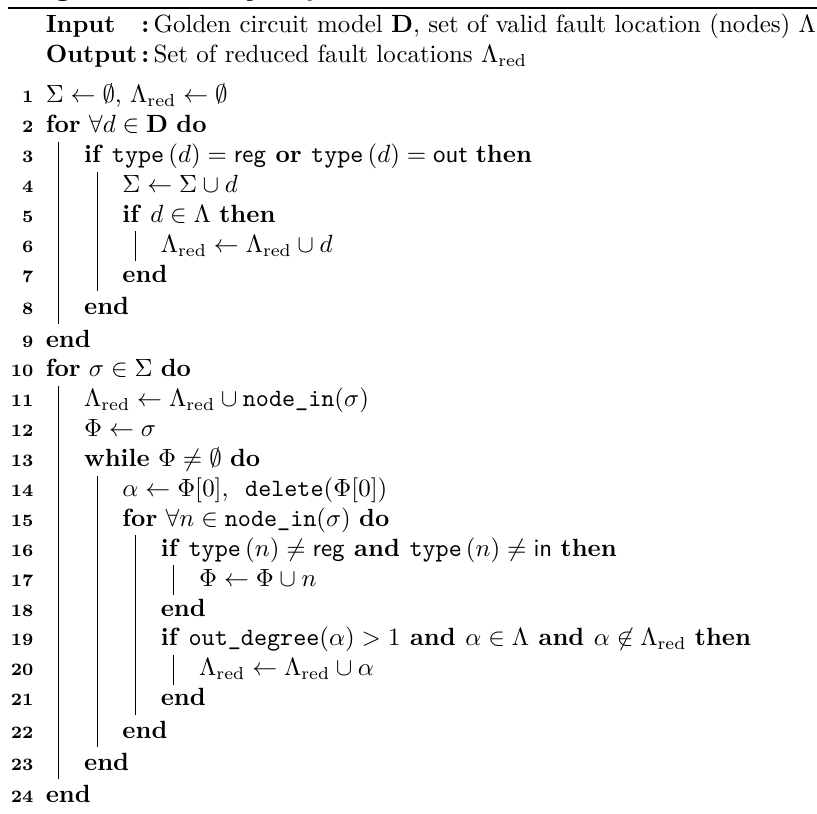
Algorithm 1: Complexity